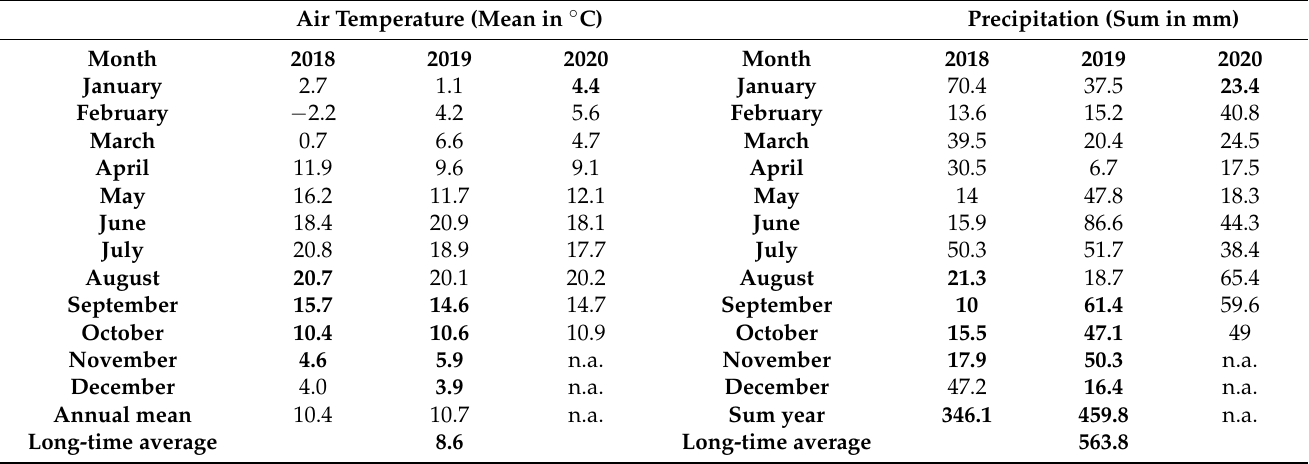
Table 2. Monthly average air temperature ( ◦ C), monthly sum of precipitation (mm), annual mean values as well as the long-time average from 1992 until 2013 (Long-time av.) during and before/after the sampling months in 2018, 2019, and 2020. All data were measured by the ZALF weather station at Dedelow (see Figure 1). The values of the sampling months and the month before the sampling of this study are